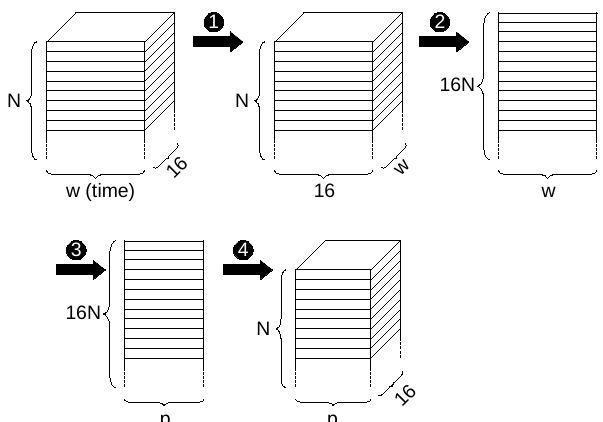
Figure 4. Steps to apply PCA reduction to 3-D input tensor: (cid:202) transposing second and third dimension, (cid:203) flattening first two dimensions, (cid:204) dimension reduction through PCA, (cid:205) converting back to original